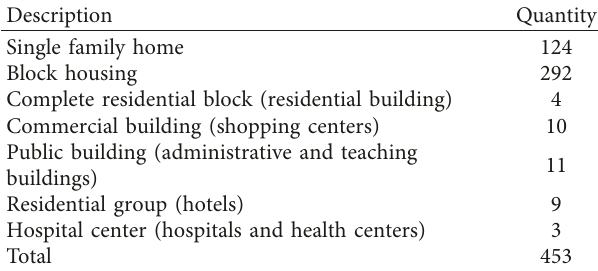
Table 1: Buildings dataset by destined